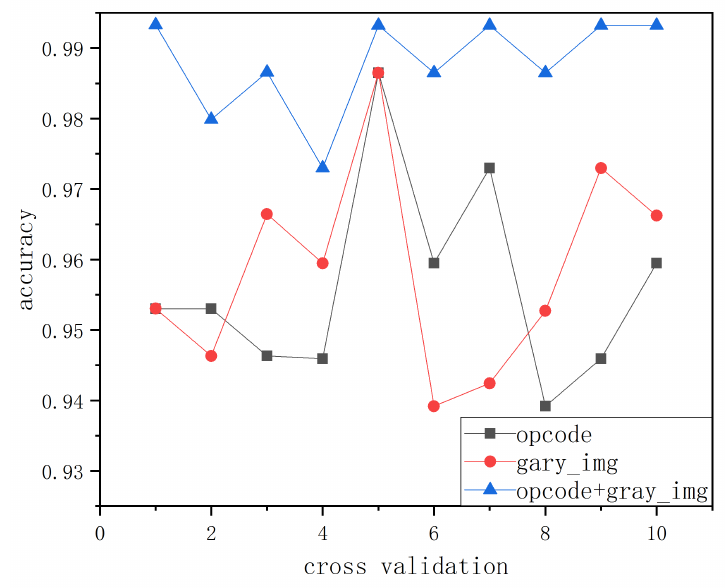
Figure 7. Simulation of single feature and fusion